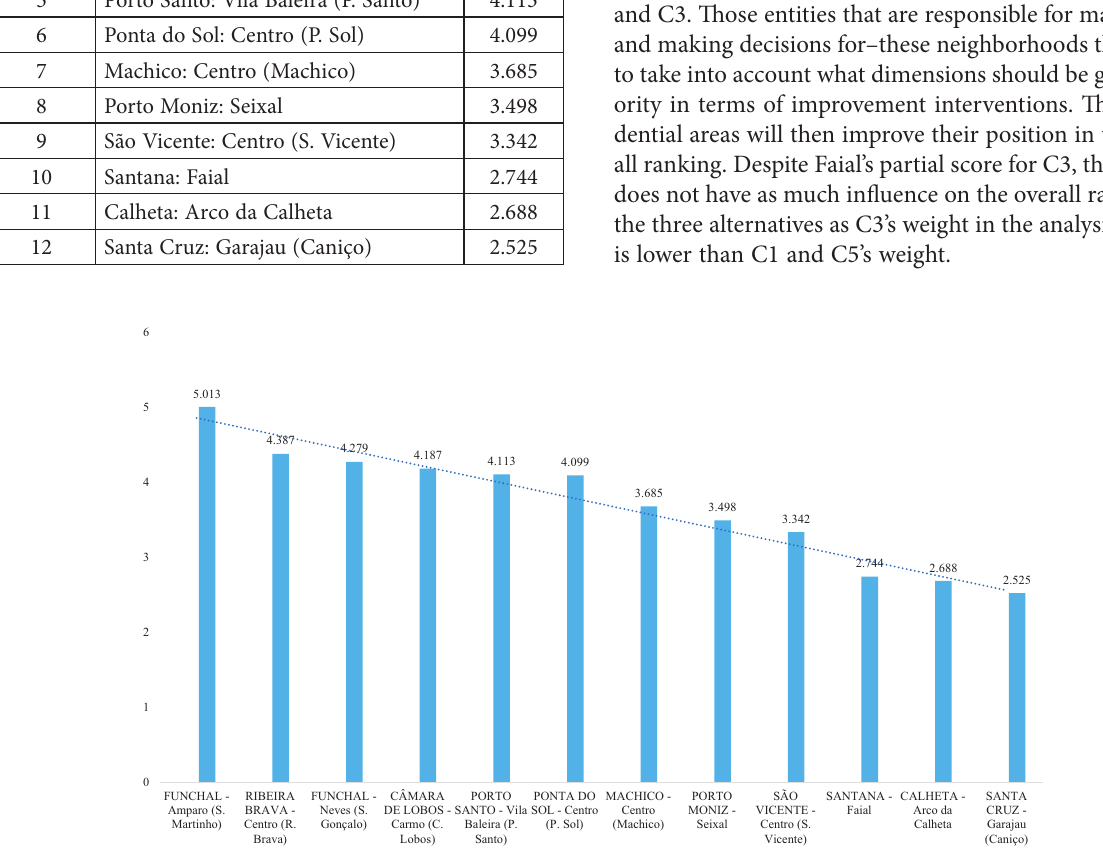
Figure 3. Madeira residential areas ranked by sustainability using